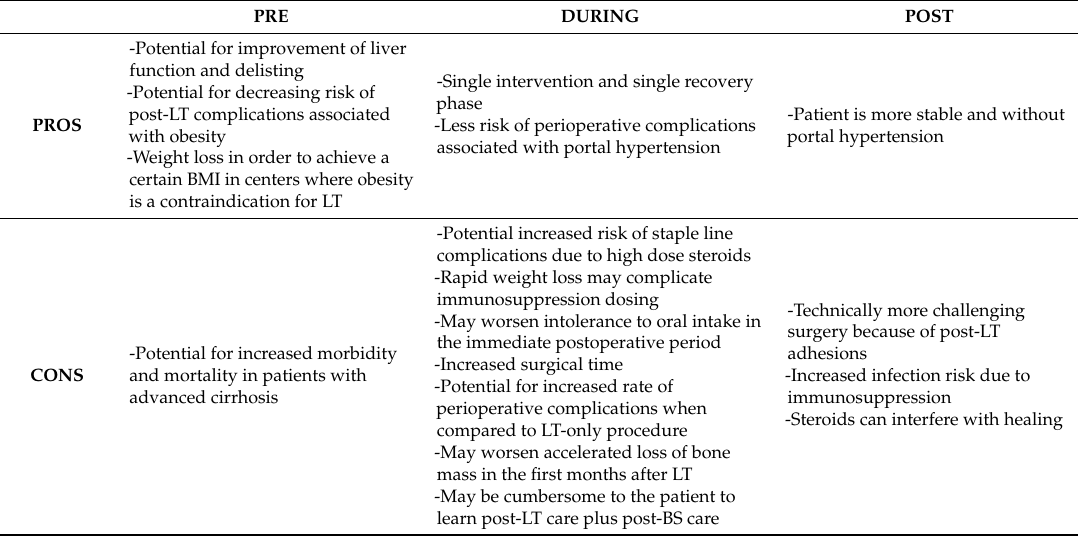
Table 1. Timing of bariatric surgery in the liver transplant